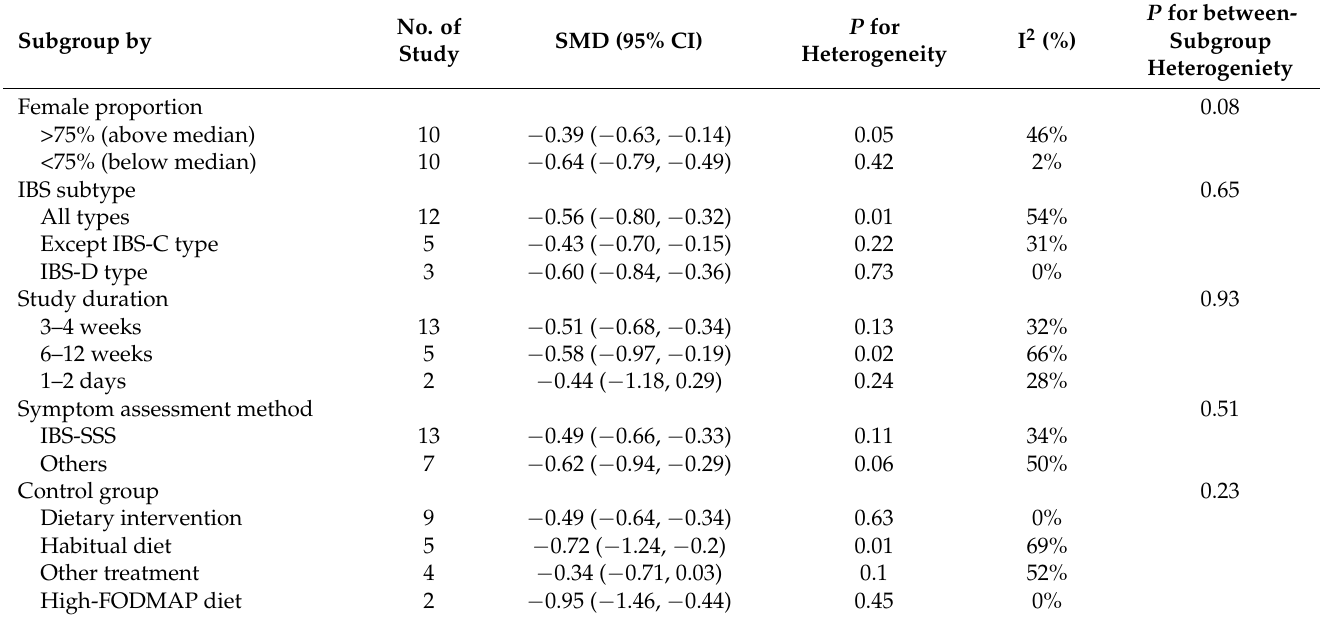
Table 2. Results of subgroup analyses for different covariates.